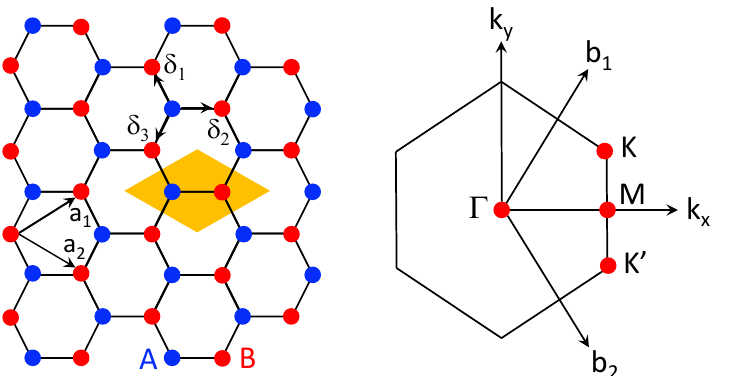
Figure 5. ( Left ) A diagram illustrating the hexagonal-lattice structure of a monolayer graphene with two sublattices A (blue) and B (red) with the Bravis lattice vectors a 1,2 and the nearest-neighbor lattice vectors δ 1,2,3 . ( Right ) the first Brillouin zone of graphene with labeled high-symmetry points Γ , M , K , K (cid:48) in the k –space with reciprocal-lattice vectors b 1,2 . In the left panel, a unit cell is shown in the shaded region in